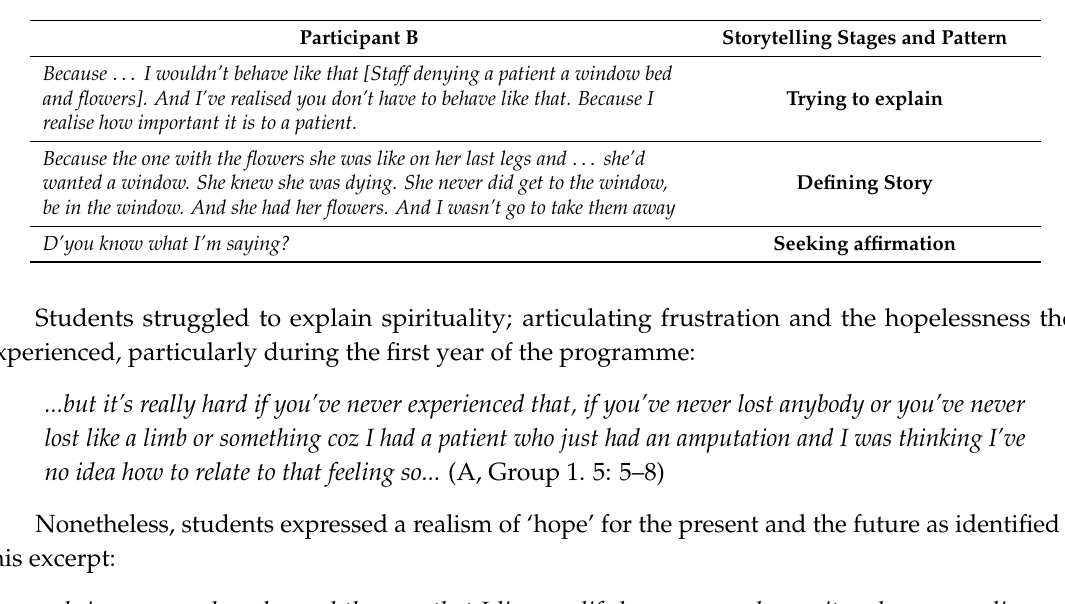
Table 2. An Example of a Defining Story from Participant